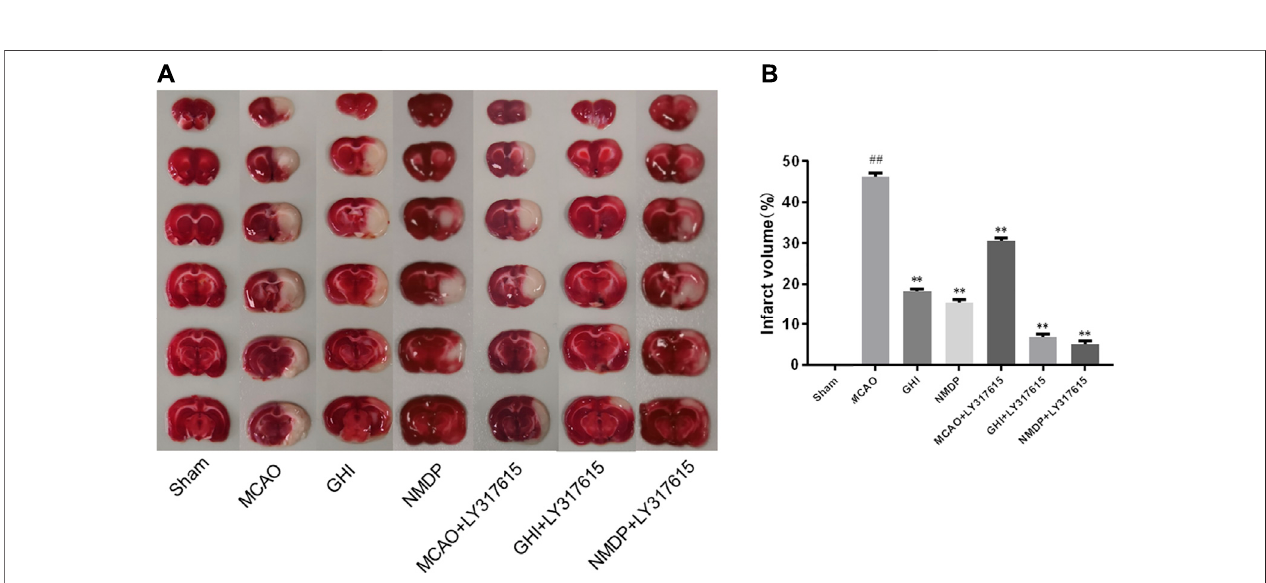
FIGURE 4 | TTC staining (A) and infarct volume (B) of each group ( x ± SD, n (cid:1) 6). #, compared with the Sham group; *, compared with the MCAO group; “ ## ” and “ ** ” means that the p value is less than 0.01; “ # ” and “ * ” means that the p value is less than 0.05.